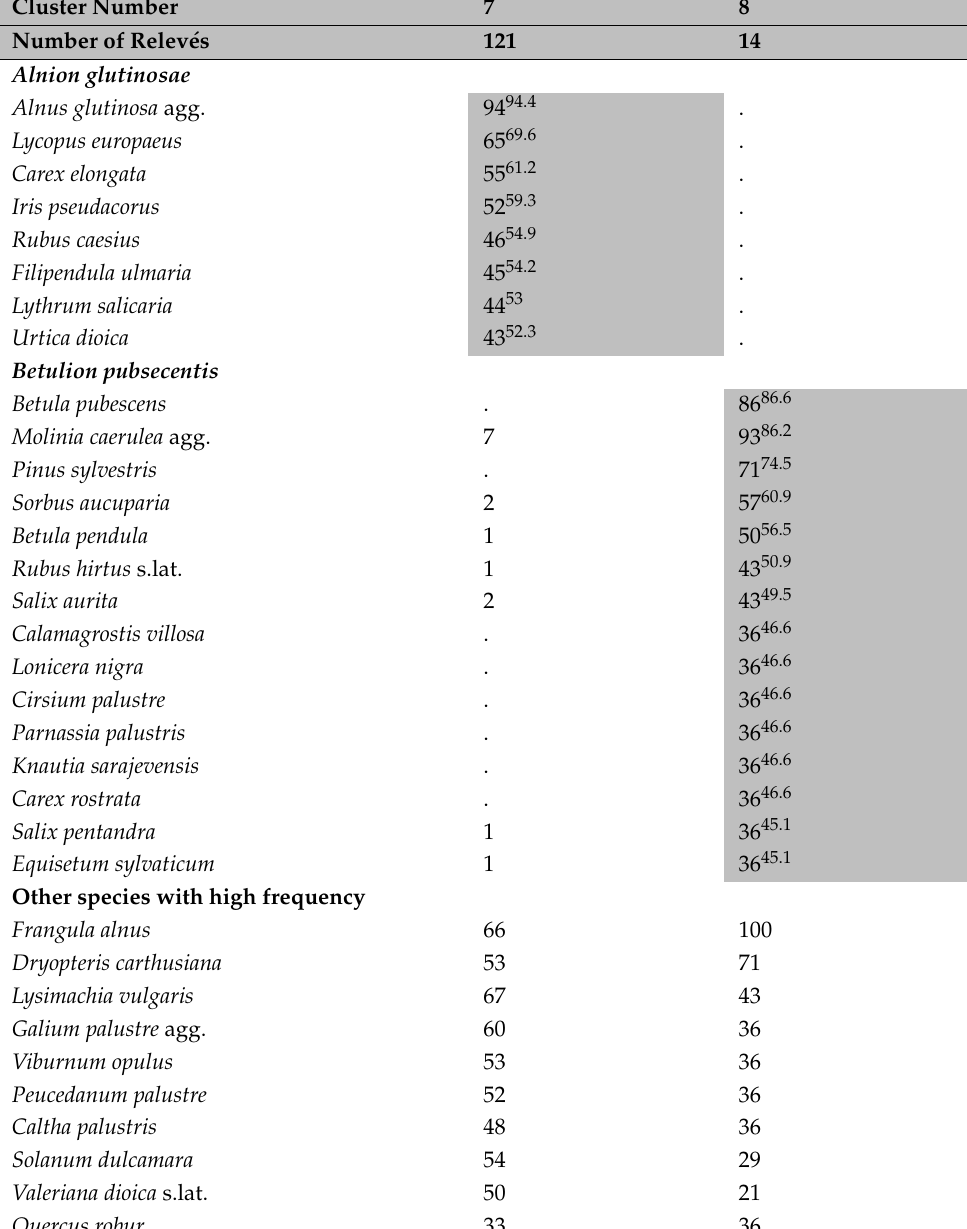
Table A3. Synoptic table for the cluster group Alnetea glutinosae . Frequencies of species are presented as percentages with phi values multiplied by 100 shown in superscript. Diagnostic species (phi values higher than 0.30) are shaded. Species with frequency lower than 30% in a cluster for which they are diagnostic are not shown. Only up to 15 species with the highest phi value are